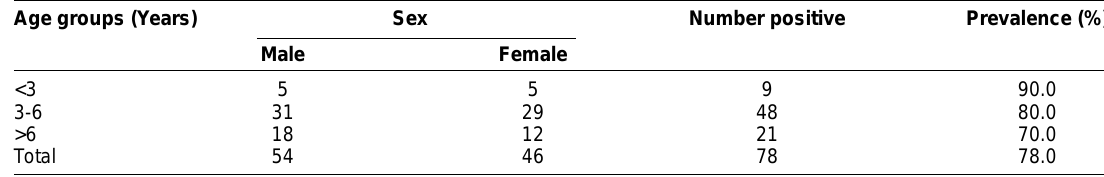
Table-3. Prevalence of gastrointestinal parasites of camels by sex in Sokoto